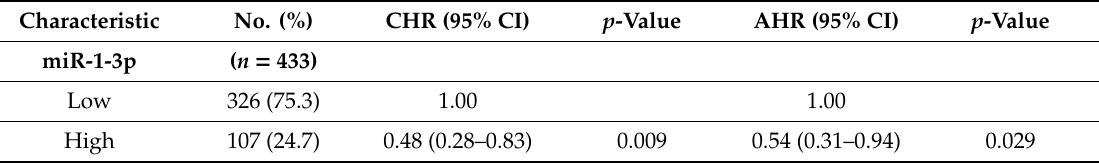
Table 5. Univariate and multivariate Cox’s regression analysis of miR-1-3p expression for overall survival of 433 patients with lung